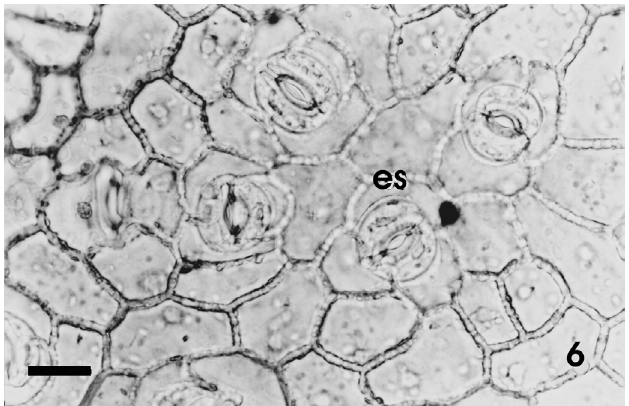
FIGURA 9 – B. trimera – Vista frontal da epiderme do